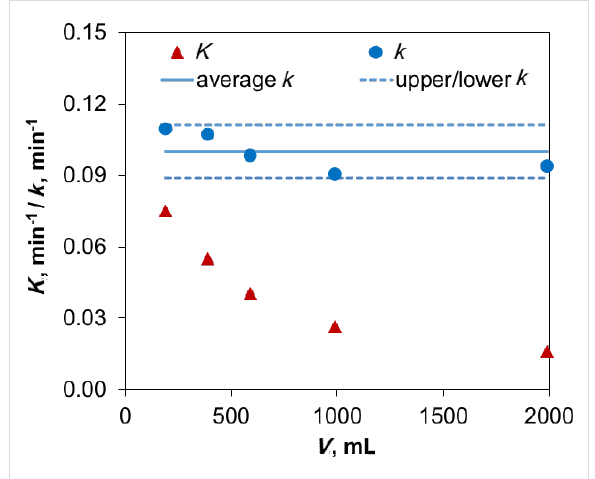
Figure 3: Apparent reaction rate constant K for the whole system and the intrinsic reaction rate constant k in the photoreactor, as a function of the volume of the mixing tank. Experiments were replicated twice and error bars of less than 2% were found, indicating the span between the minimum and maximum values are included in the markers and prove the precision of the